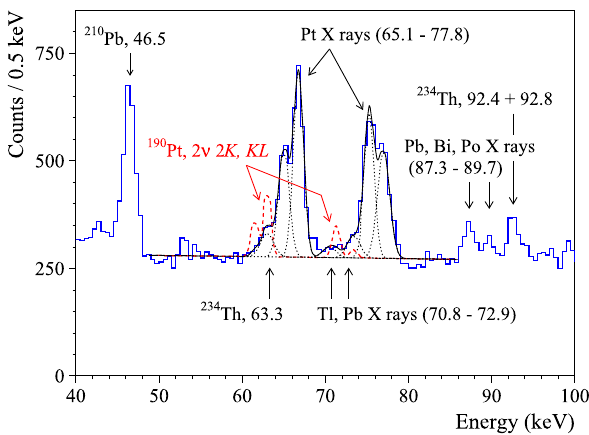
Fig. 5 The energy spectrum collected with the Pt sample by the HPGe detectorsystemintheenergyregionwhere K X-rayquantaareexpected for the 2 ν 2 K and 2 ν K L decays of 190 Pt. The fit of the data by the background model is shown by solid line, the peaks included in the model of the background are shown by dotted lines, while the excluded effectispresentedbydashedline(theexcludeddistributionismultiplied by a factor 2 to improve visibility). Energy of γ and X-ray quanta are in